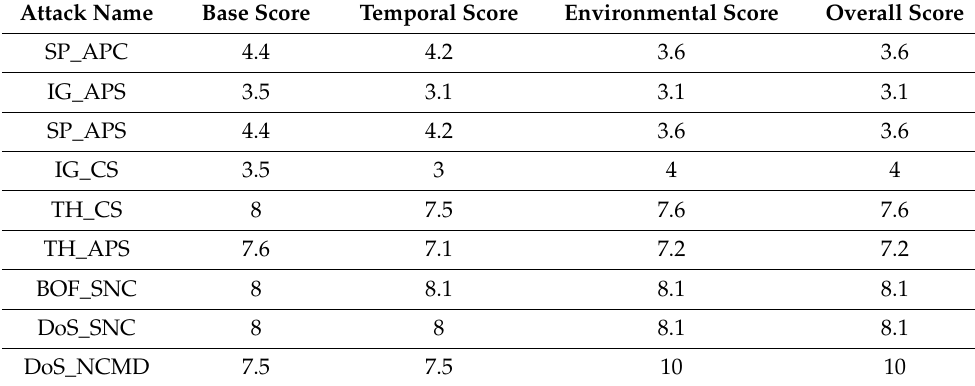
Table 1. Attacks’ CVSS